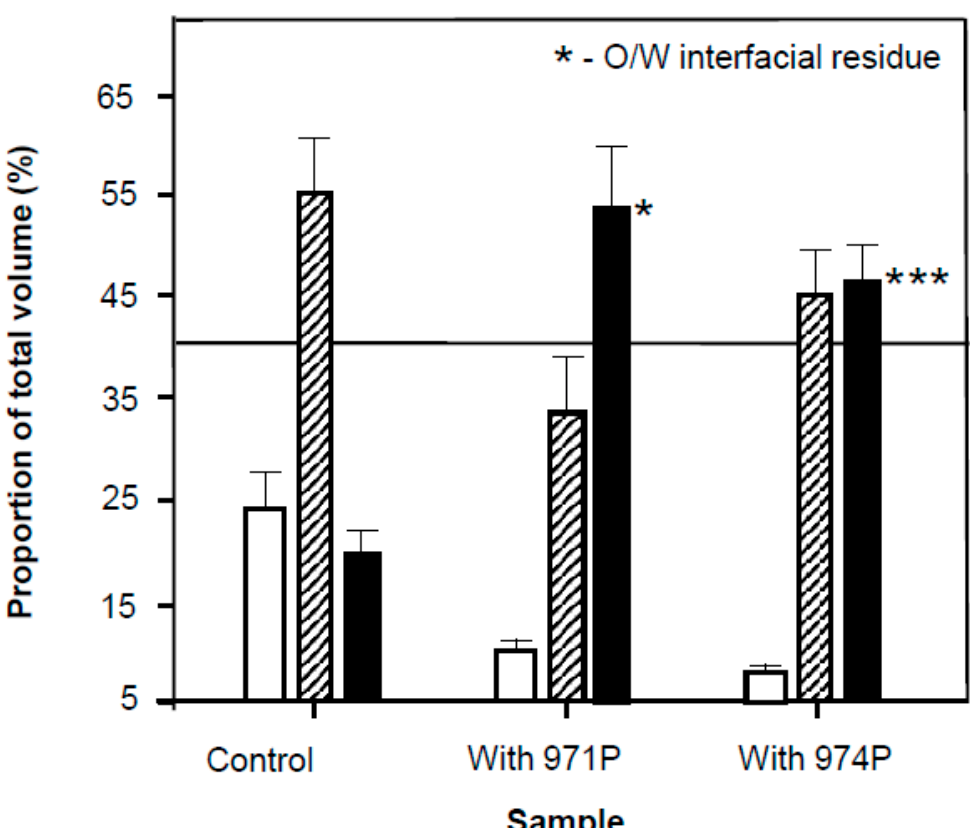
Figure 9. The proportion of various phases of preformed emulsions in the absence and in the presence of carbopol (test system) in the aqueous phase at 20 °C in the presence of 1 × 10 − 5 M sodium azide. The control sample only contained 1 mM Tween and 0.65 mM betamethasone 21-phosphate, whereas the other samples contain 0.5% w / v carbopol 971P and carbopol 974P. The relative proportion as part of the total sample of oil (unfilled bars), discernible intact emulsion (hatched bars) and aqueous portion with some degree of opacity (solid bars) are presented. The horizontal line is intended as an aid to the eye and indicates the proportion of oil incorporated into the emulsion. Both carbopol containing samples showed evidence of interfacial phase separation but notably the carbopol 974P sample showed evidence on inspection more than 10 min after preparation of a clearly visible 1–2 mm interface ‘sludge’. The sludge is presumed to consist of droplets and polymer chains of sufficient colloidal dimensions to remain suspended. All solutions used for samples were prepared from surface chemically pure 50 mM sodium phosphate buffered water, pH 7.0. Asterisks indicated in the plot point to the amount of interfacial residue (* - slight residue; *** - triple the volume of residue seen in the former).